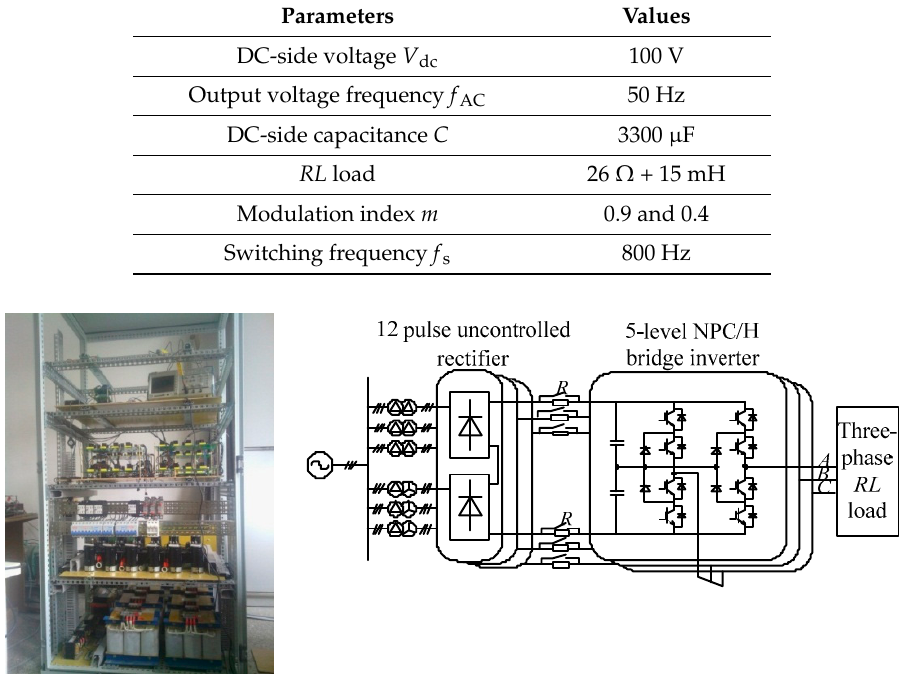
Table 4. The experimental parameters of the system.